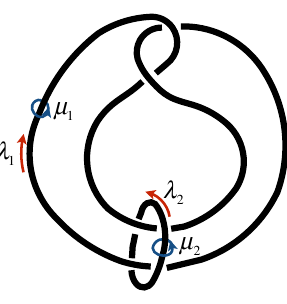
Figure 4 . Whitehead link ( 5 2 two-component hyperbolic